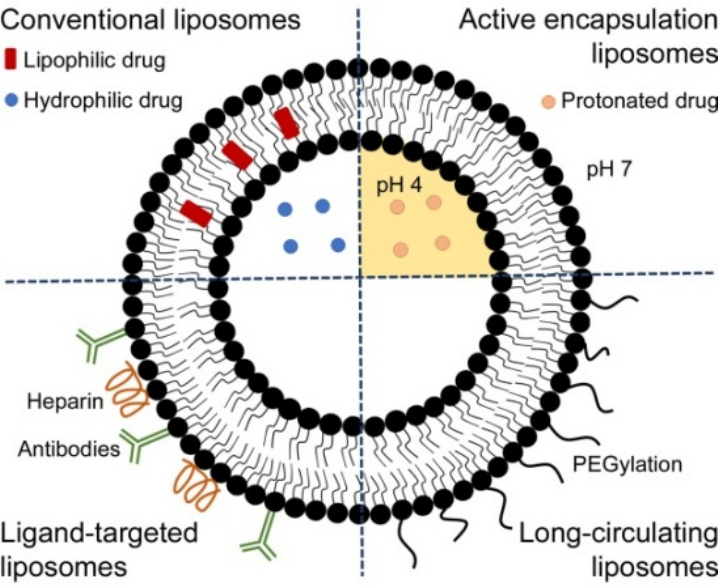
Figure 2. Schematic representation of liposomes formulated using different strategies aiming at improving the therapeutic efficacy of encapsulated drugs and the presentation of vaccine antigens. Conventional liposomes are formed by phospholipids and cholesterol and can encapsulate hy- drophilic drugs in their aqueous cores and hydrophobic compounds in their phospholipid bilayers.